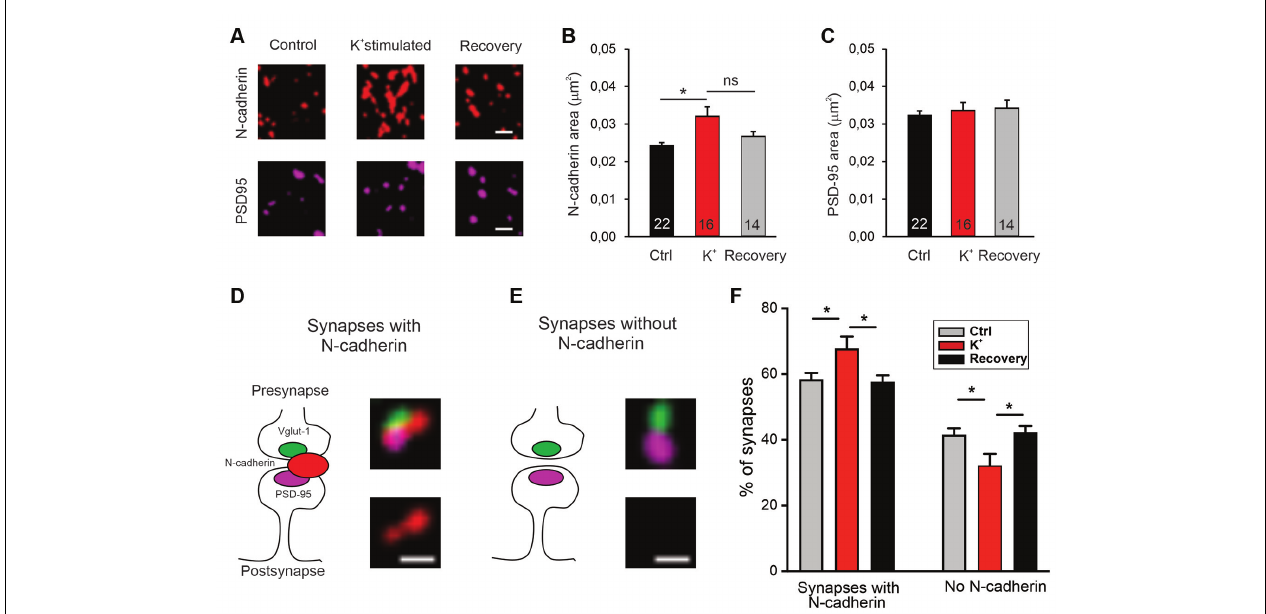
FIGURE 7 | Recruitment of N-cadherin to glutamatergic synapses upon strong stimulation of vesicle release by high extracellular [K + ]. (A–C) Structured illumination microscopy (SIM) revealed a significant increase in N-cadherin puncta area upon strong synaptic vesicle release induced by high extracellular [K + ] (50 mM) in cultured cortical neurons (DIV 13–14). (A) Example images showing N-cadherin (upper panel) and PSD95 (lower panel) immunostaining in non-stimulated control cells ( left ), in 50 mM K + stimulated cells ( middle ), and after 30 min recovery from K + stimulation ( right ). Scale bar: 0.5 µ m. (B) Quantification of mean N-cadherin puncta area (control: black; K + stimulated: red; after recovery: gray). Means ± SEM, n = 22/16/14 dendrites (from four experiments). K + stimulation resulted in a significant increase in N-cadherin puncta area. P = 0.014. (C) Quantification of mean PSD95 puncta area. Statistics were done using Kruskal-Wallis one-way ANOVA on Ranks with Dunn’s post hoc test, ns: non significant, * P < 0.05. (D,E) Schematic diagrams ( left ) and corresponding SIM overlay images ( right ) of glutamatergic synapses depicting two synapse categories as defined by the spatial expression of N-cadherin (red) in relation to VGLUT1 (presynaptic marker, green) and PSD95 (postsynaptic marker, magenta). (D) Synapses with cleft associated N-cadherin: N-cadherin is in close contact with synaptic cleft (at least at peri-active zone, left ). Example SIM images showing VGLUT1, PSD95, N-cadherin signal overlay ( upper right ), and corresponding N-cadherin signal alone ( lower right ). (E) Synapses without N-cadherin expression ( left ). Example SIM images showing signal overlay ( upper right ) and absence of N-cadherin ( lower right ). Scale bar: 0.25 µ m. (F) Quantification of the percentage of synapses in the two categories defined above (D,E) for non-stimulated controls (gray), in 50 mM K + stimulated cells (red), and after 30 min recovery from K + stimulation (black). Strong release of synaptic vesicles by K + stimulation led to a significant increase in the number of synapses with cleft associated N-cadherin. n = 12 dendrites (from four experiments). P = 0.041 (ctrl vs. K + stim.); P = 0.026 (K + stim vs. recovery). Statistical analysis was done using one-way ANOVA with Tukey post hoc test, * P < 0.05. The two complementary categories were tested